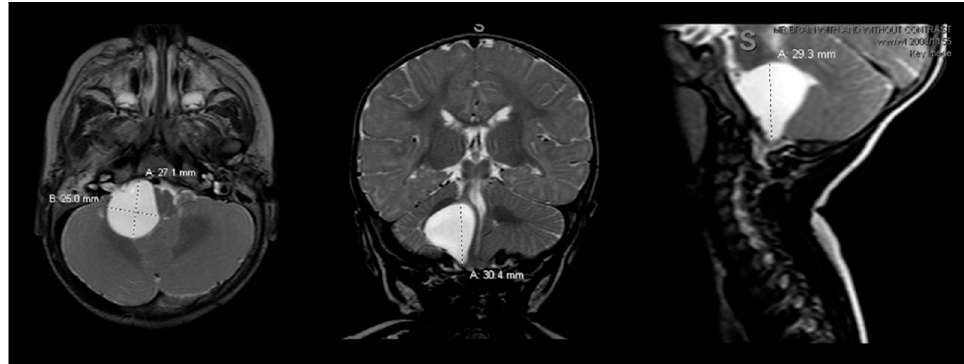
Figure 1. Preoperative brain MRI scan. The preoperative brain MRI scan (left = axial; middle = coronal; right = sagittal) T2 sequences showed a large 2.5 × 2.7 × 3.0 cm homogeneous, hyperintense right cerebellopontine angle cystic lesion causing mass effect on the right pons and medulla. T1 sequences (not shown) were hypointense for the cyst, without contrast enhancement on gadolinium scans. MRI = magnetic resonance imaging.